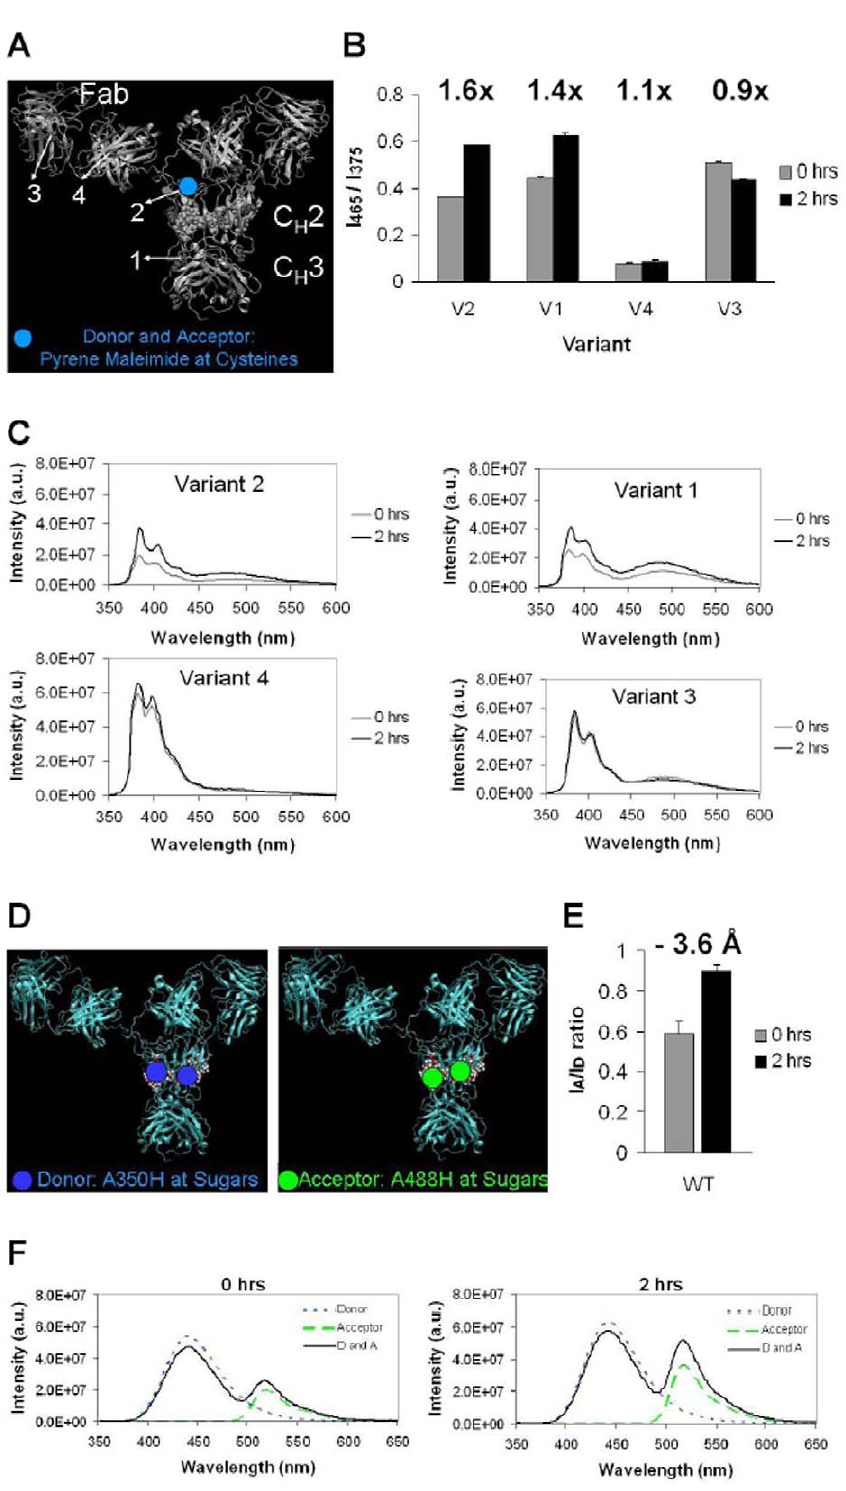
Figure 3. Protein-protein and carbohydrate-carbohydrate interactions in the C H 2 domain increase upon stress. (A) Protein intermolecular interactions via pyrene-labeled cysteine variants. (B) Excimer ratio of non-stressed (0 hrs) and stressed (2 hrs at 60 u C) samples. The numbers above the pair of columns for each variant indicate the ratio of stressed (value of column in black) to unstressed (value of column in grey) sample ratios. (C) Emission spectra of pyrene-labeled variants. (D) Experimental set-up for analyzing carbohydrate intermolecular interactions. Antibody samples with carbohydrates labeled with donor, A350, or acceptor, A480, were analyzed separately and as a mixture. (E) Ratios of acceptor and donor intensity in the mixed samples before and after stress at 60 u C for 2 hours. The change in intermolecular average distance between the fluorophores after stress is shown above the columns. (F) Fluorescence spectra of Donor only, Acceptor only, and Donor and Acceptor mixture for each condition.